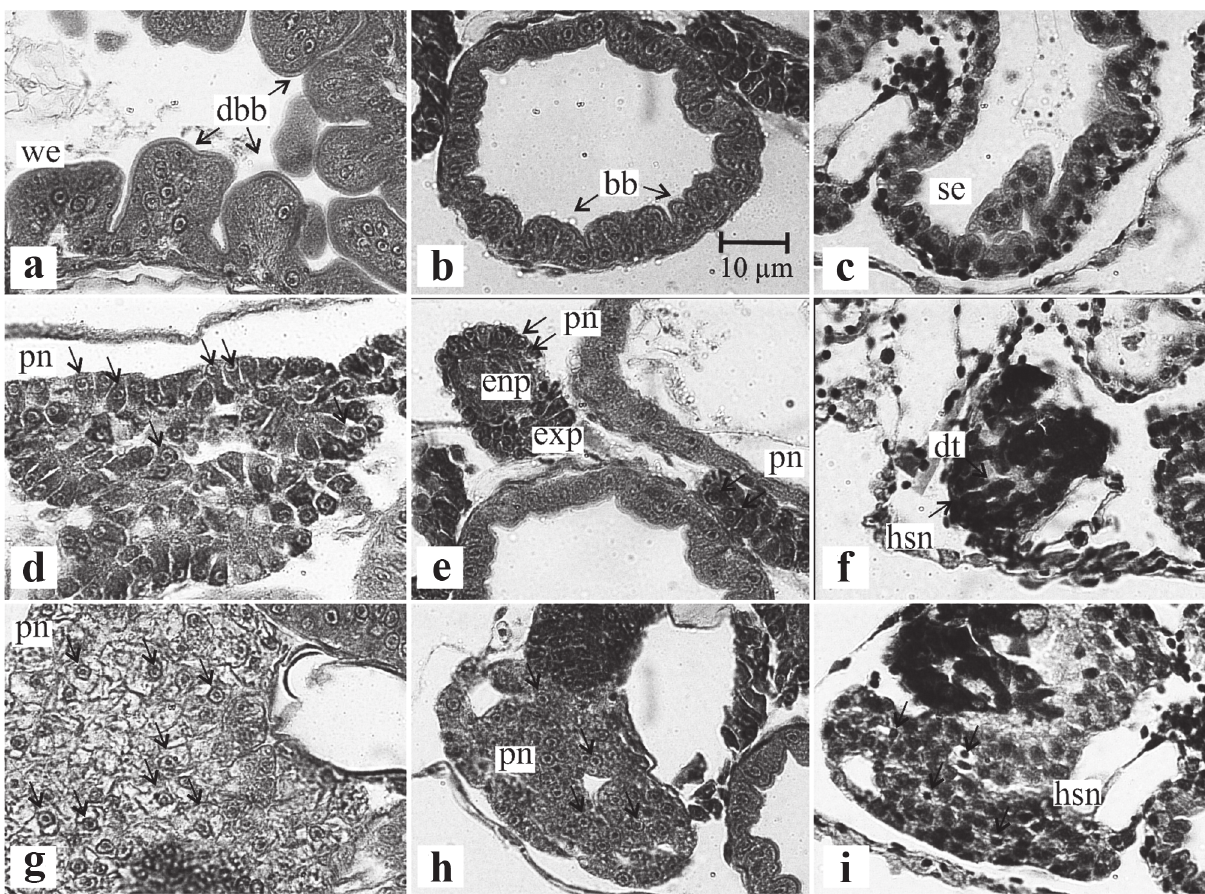
Fig. 3. Histological sections of Pagrus pagrus larvae, indicators of short term nutritional condition. Sagital section of 4 µm thick stained with Harris’s hematoxylin and eosin counterstain (H-E). ( a-c ) digestive duct, ( d-f ) pancreas, ( g-i ) liver; left = fed larvae, middle = delayed fed lavae and right = starved larvae. bb: brush border, dbb: distinct brush border, dt: dissociated tissue, enp: endocrine pancreas, exp: exocrine pancreas, hsn: heavily stained nucleus, pn: prominent nucleus, se: shrunken enterocytes, we: wide enterocytes. Scale bar indicates 10